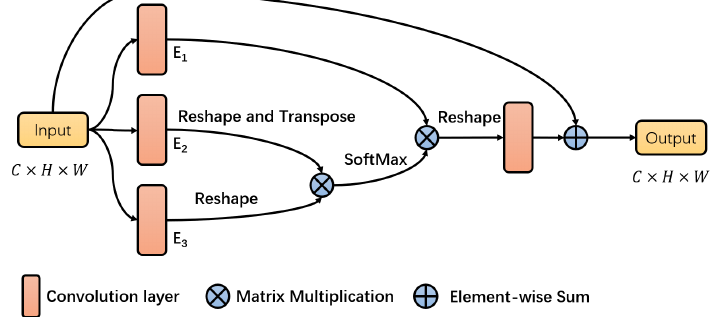
Figure 2. The detailed architectures of the spatial attention block in CSAR.